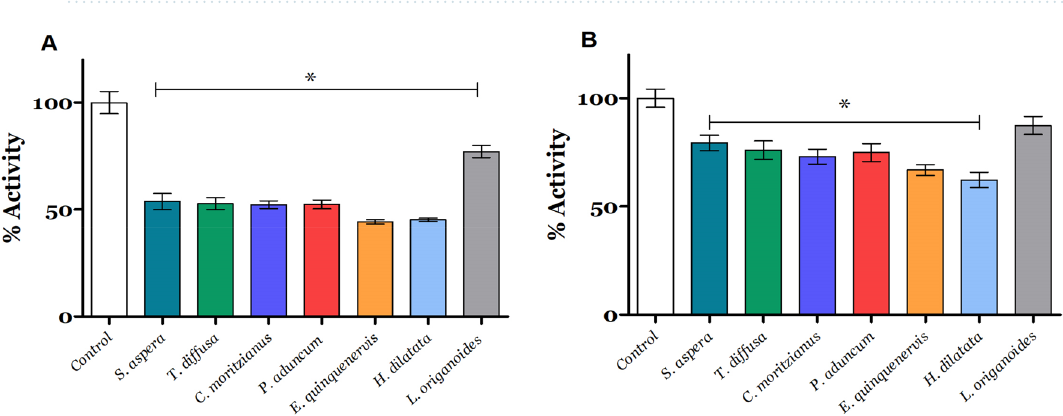
Figure 3. Effect of EOs on acetylcholinesterase activity. ( A ) A. aegypti larvae; ( B ) commercial Acetylcholinesterase from Electrophorus electricus. All values were normalized with respect to the negative control value representing 100% activity with 3.37 nmol of reduced DTNB/min −1 mg −1 of total protein and 9.33 nmol of reduced DTNB/min −1 mg −1 of total protein (0.1 mg), respectively. Each value represents